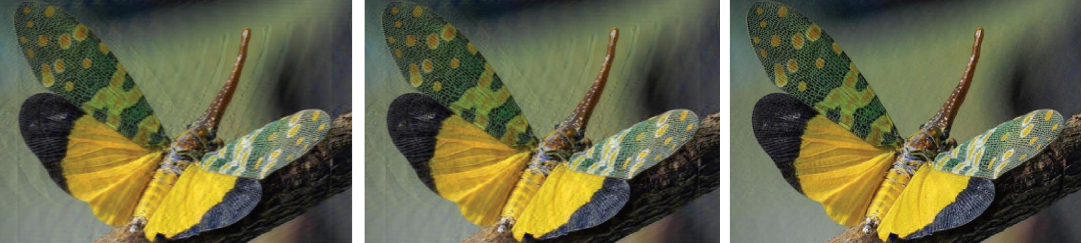
Figure 5: Rebuilt images degraded by blurred matrices M